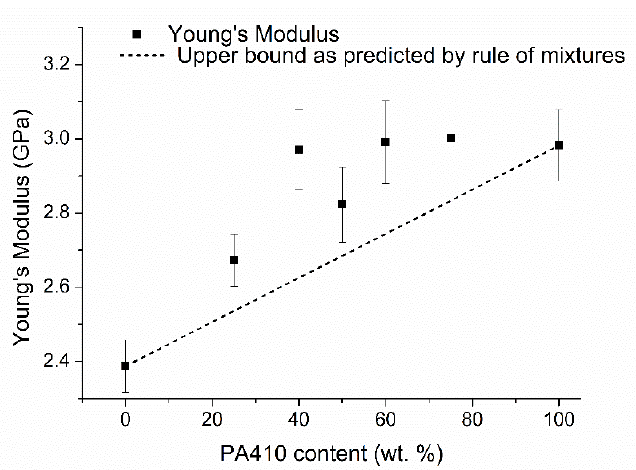
Figure 2. Comparison between the theoretical upper bound of the Young’s Modulus predicted by